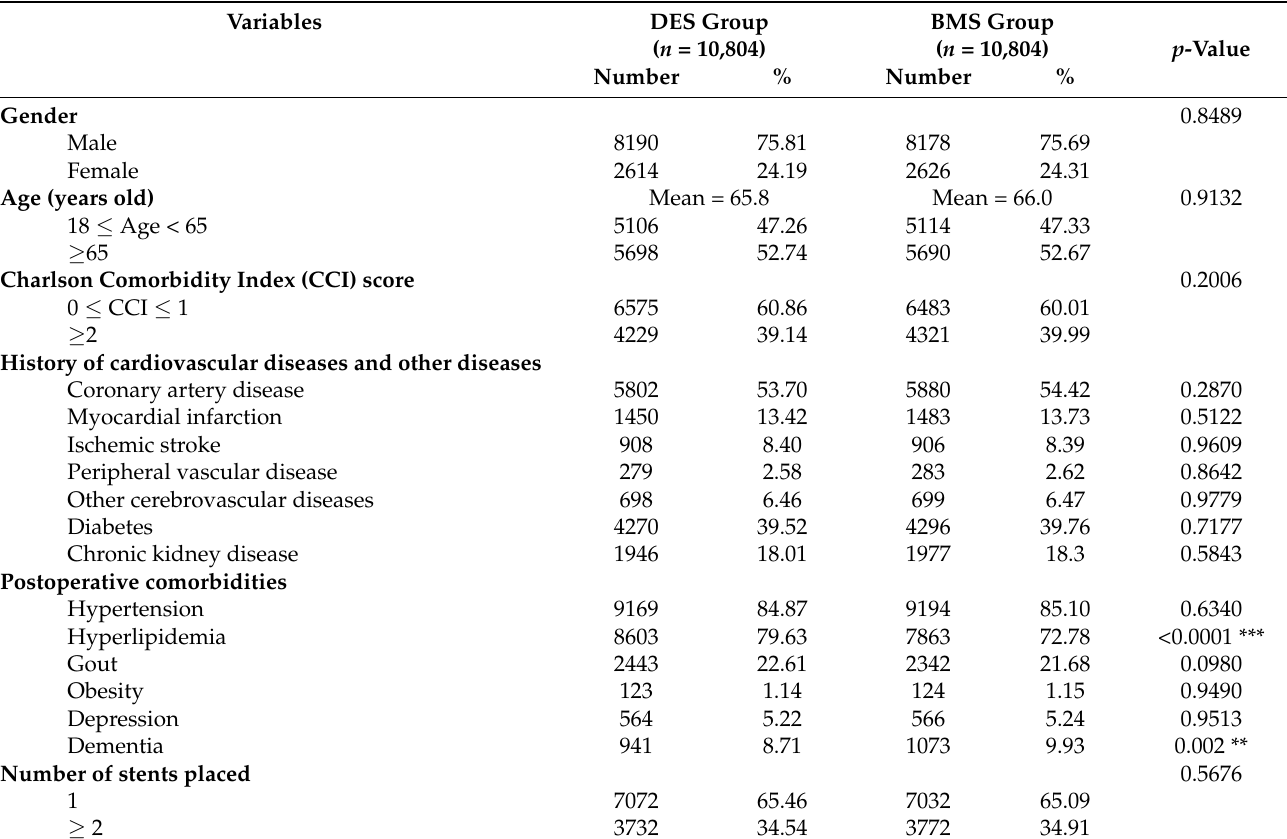
Table 1. Baseline characteristics of patients with coronary stent